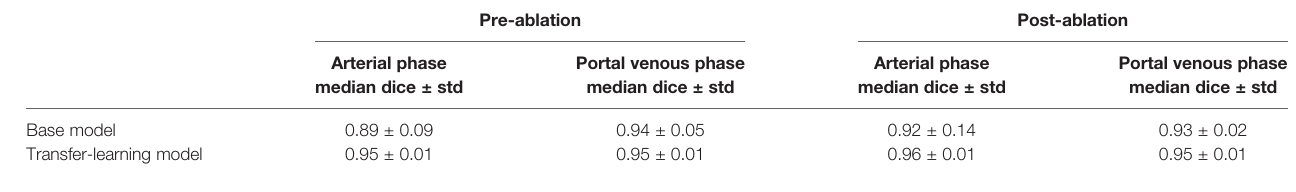
TABLE 3 | Results of liver segmentation model in clinical